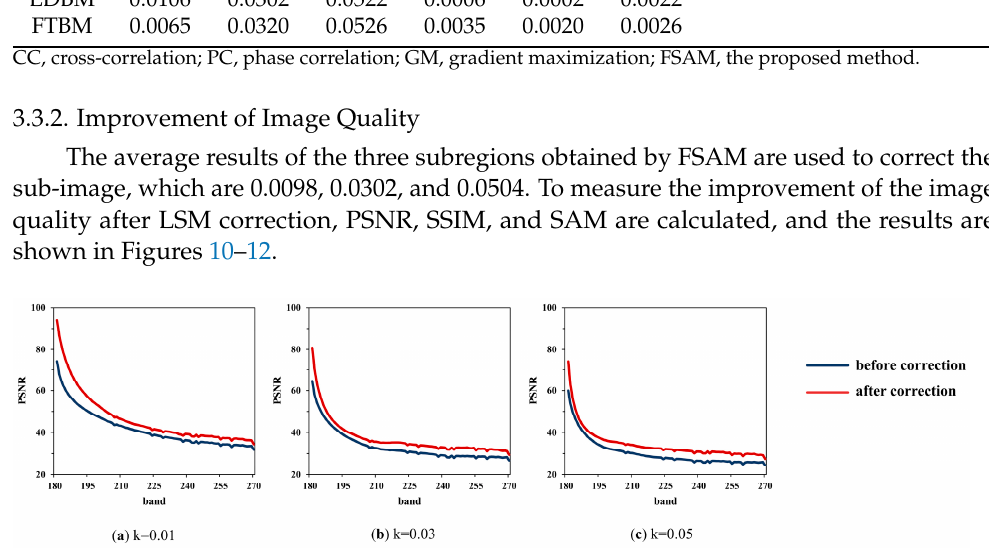
Figure 11. SSIM of each band between original image and images with 𝑘 of ( a ) 0.01; ( b ) 0.03; and ( c ) 0.05.